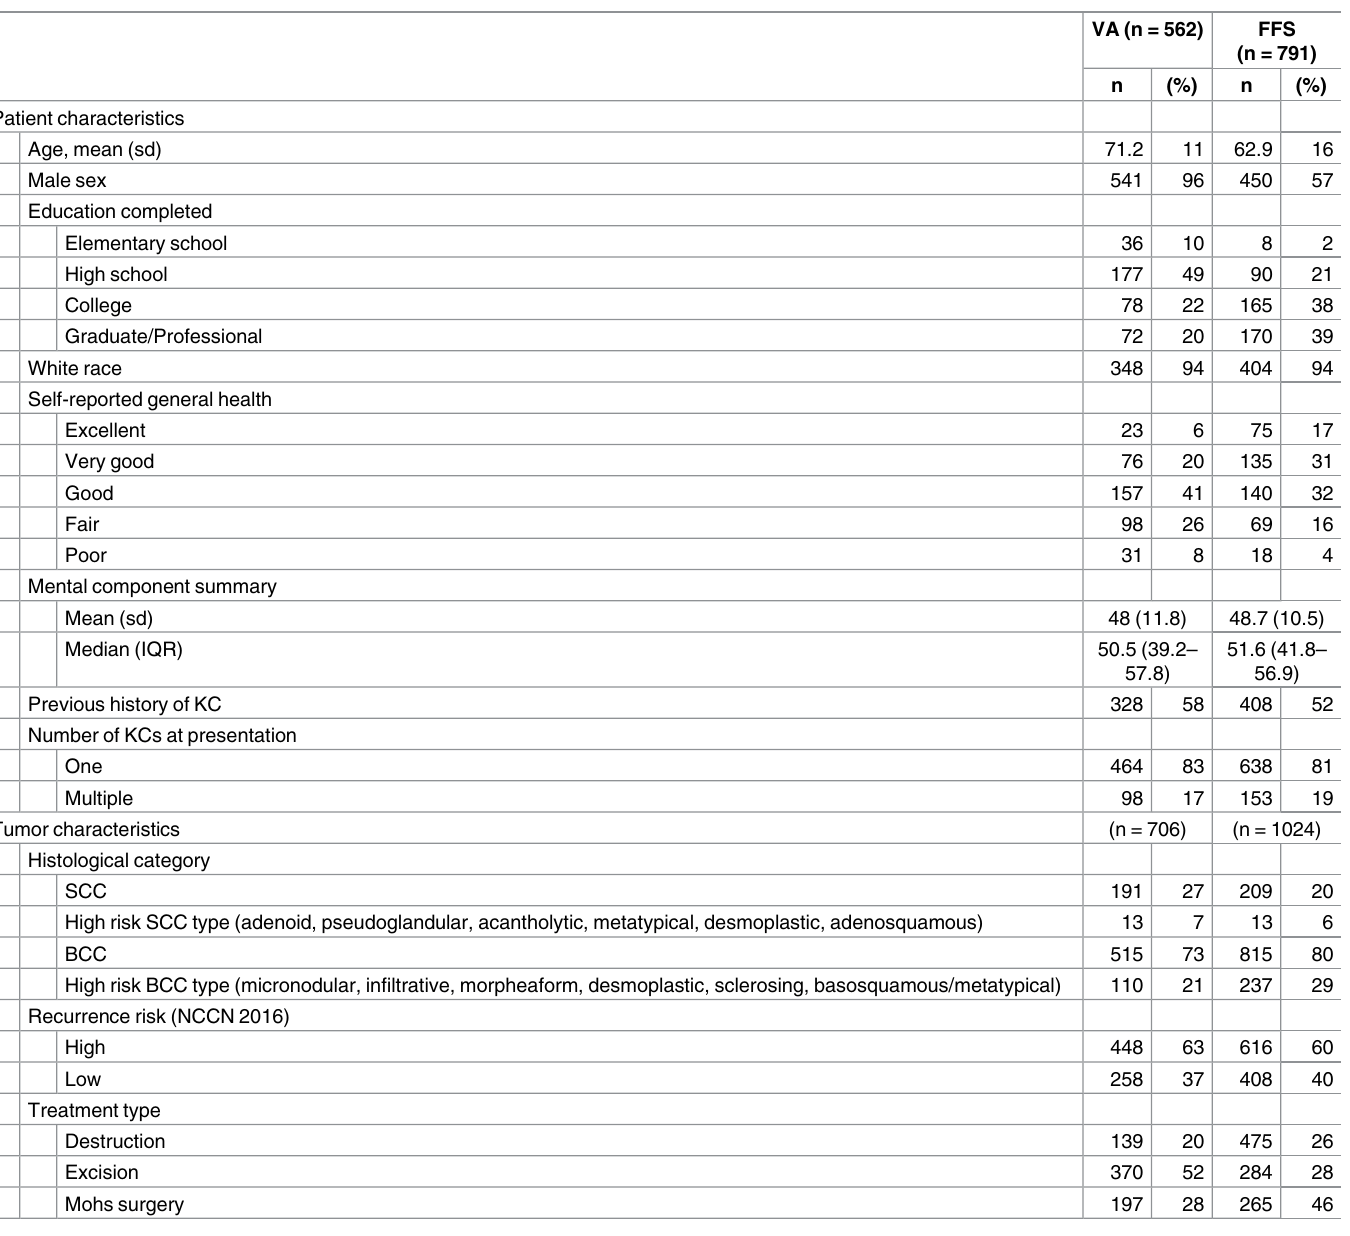
Table 1. Patient and Tumor Characteristics. This finding was consistent in a Cox proportional hazard model, which included treatment type, risk for recurrence [17,18], multiple KCs at presentation, and > 2 annual dermatology visits during the follow-up period: hazard ratio of 0.79 [0.42–1.49] (P = 0.46) at the VA com- pared to FFS. Kaplan-Meier curves for tumor recurrence by treatment type were not signifi- cantly different (S3 Fig).